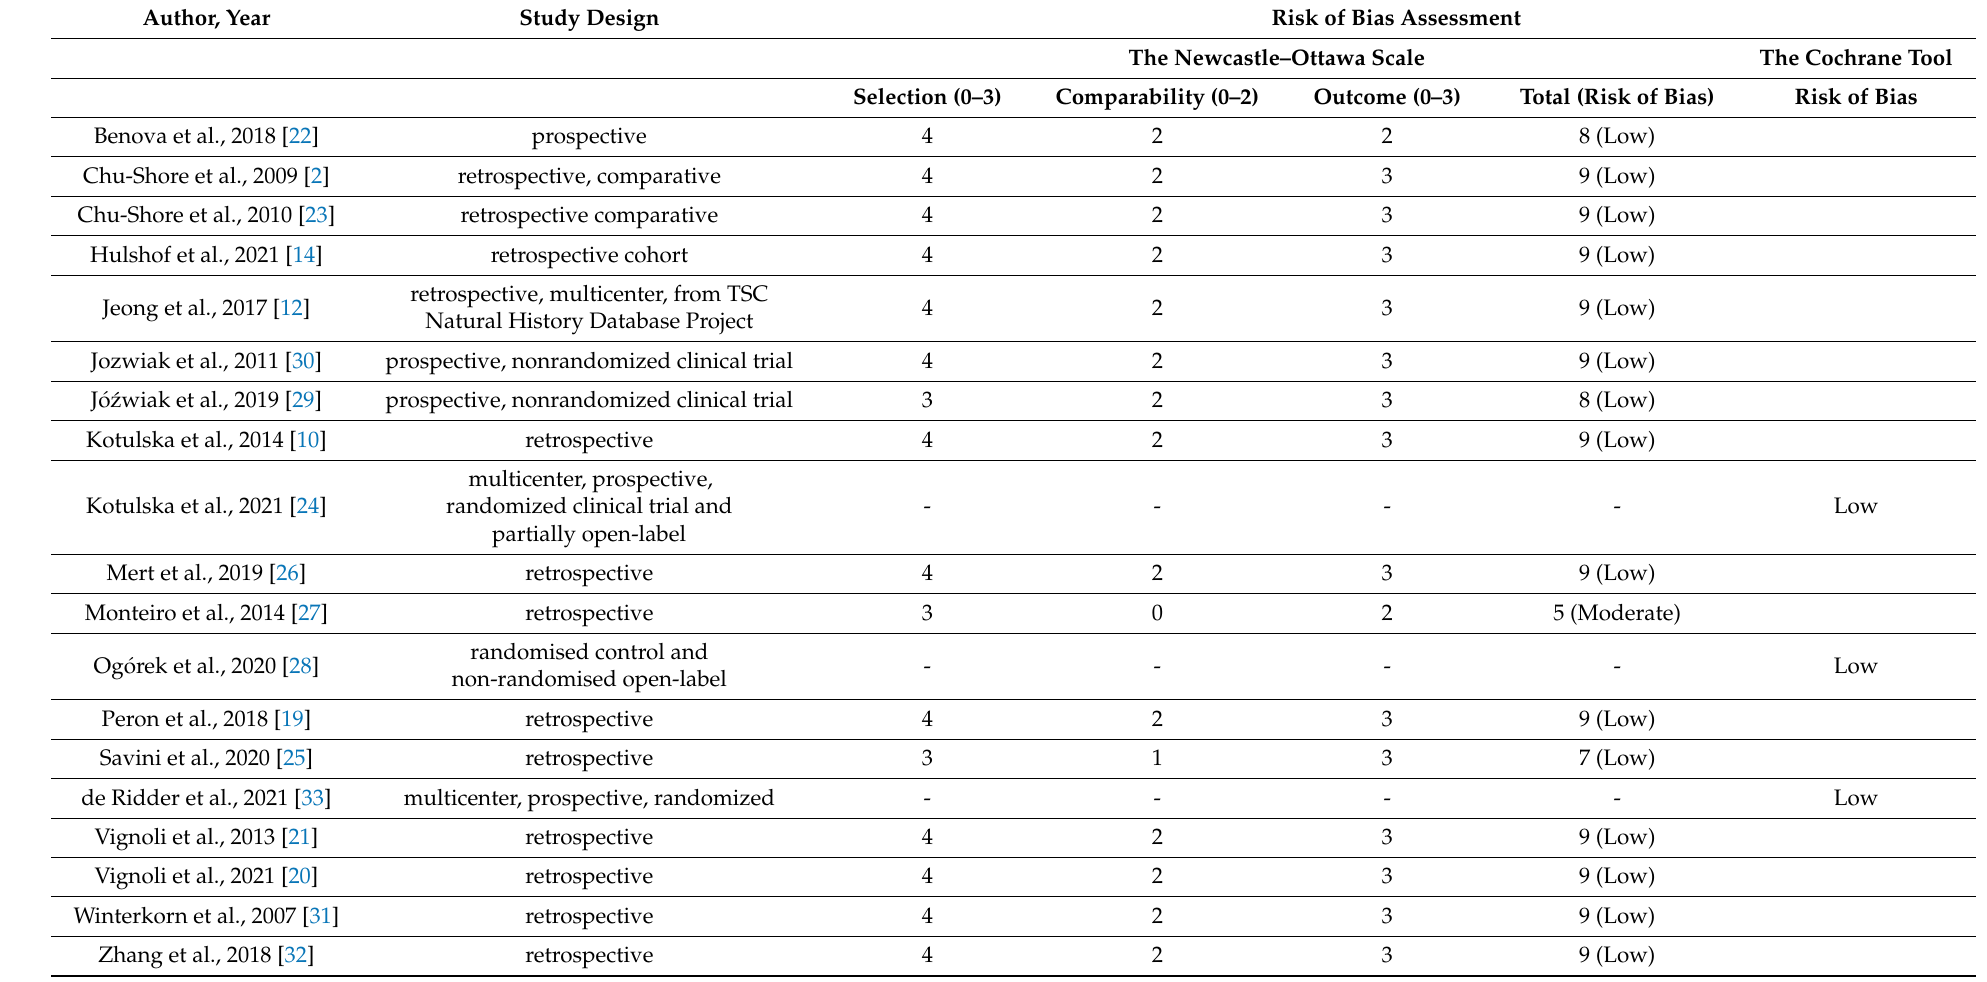
Table 2. Methodic assessment of the included